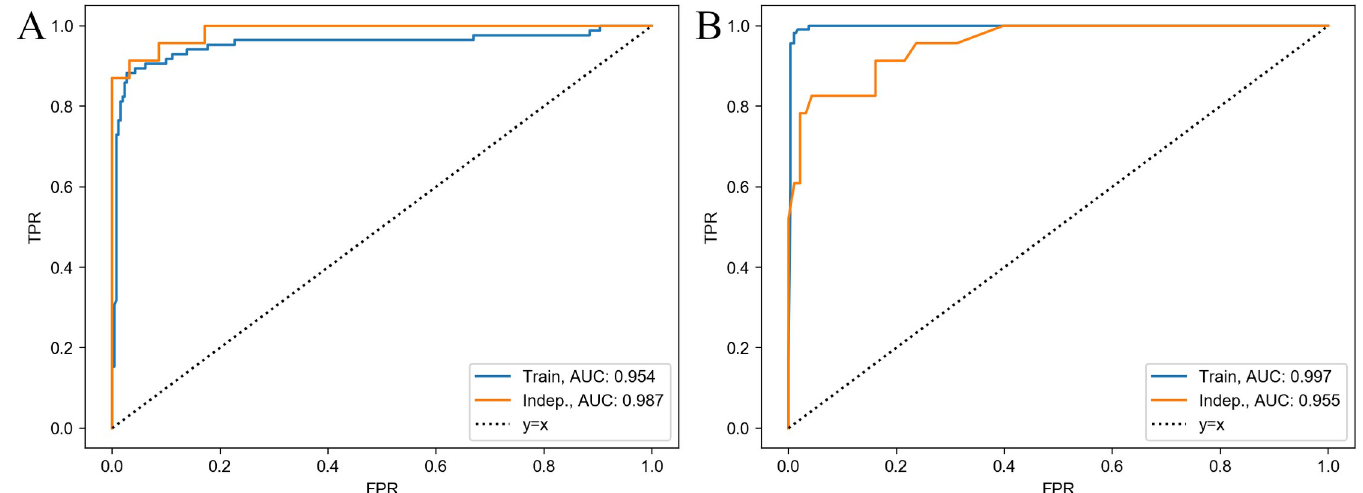
Fig 5. Receiver Operating Characteristics (ROC) curves of classifier performance to diagnose progressor Mtb -infected DO mice. A) Logistic Regression with MMP8, and B) Gradient Tree Boosting with CXCL1, CXCL2, TNF, and IL-10. Blue and orange curves correspond to the AUC in the discovery cohort (n = 345 for A and n = 407 for B) and independent cohort (n = 116) respectively for both A and B.